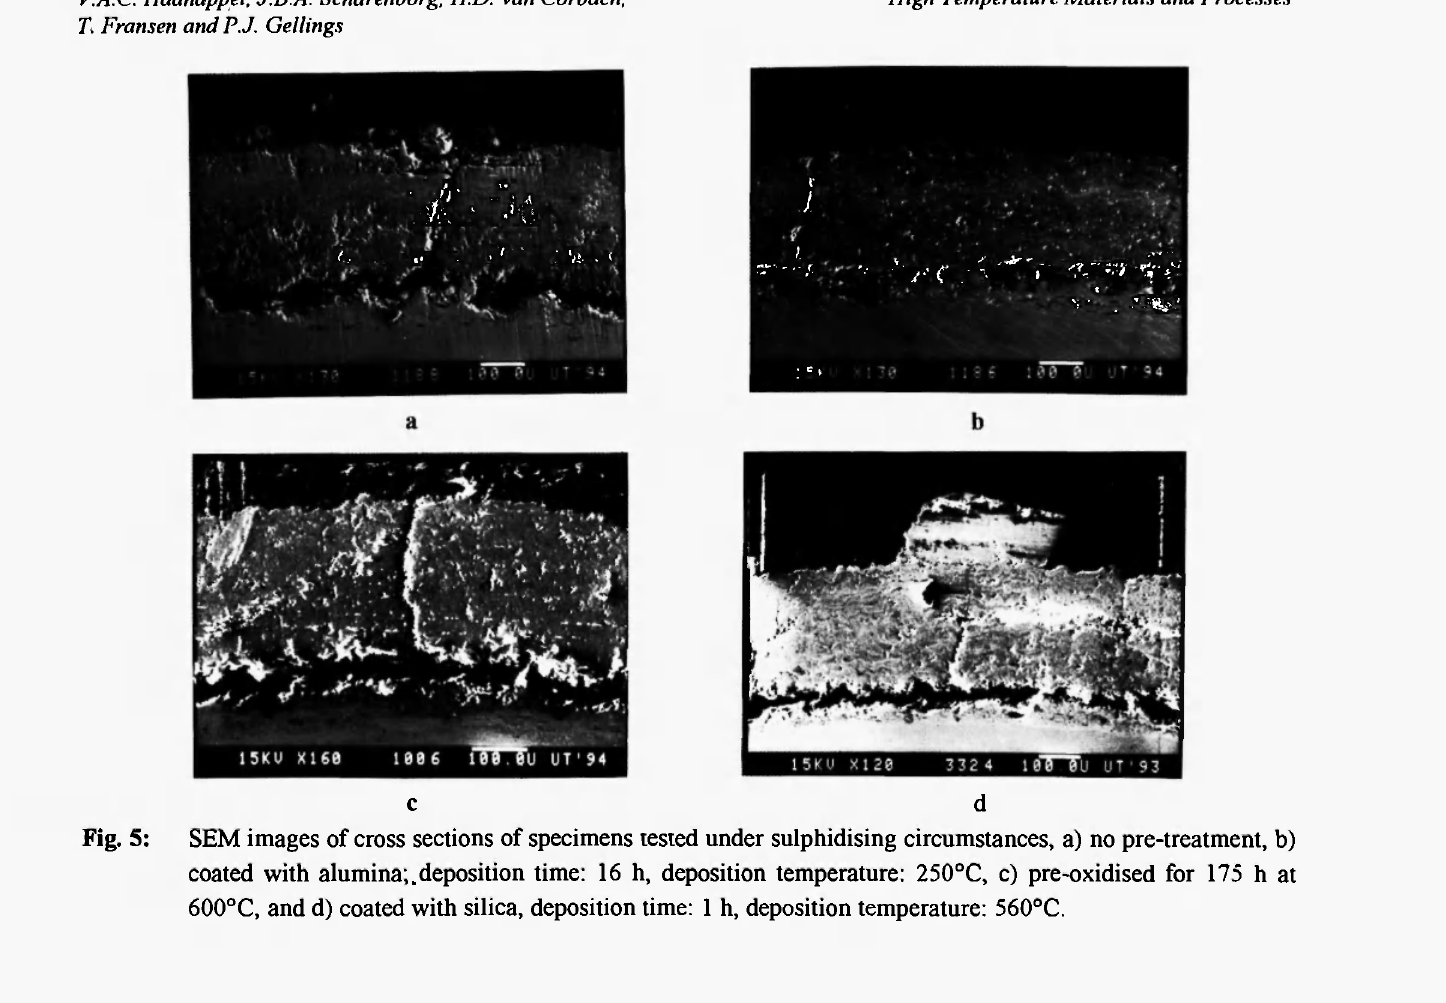
SEM images of cross sections of specimens tested under sulphidising circumstances, a) no pre-treatment, b) coated with alumina;.deposition time: 16 h, deposition temperature: 250°C, c) pre-oxidised for 175 h at 600°C, and d) coated with silica, deposition time: 1 h, deposition temperature: